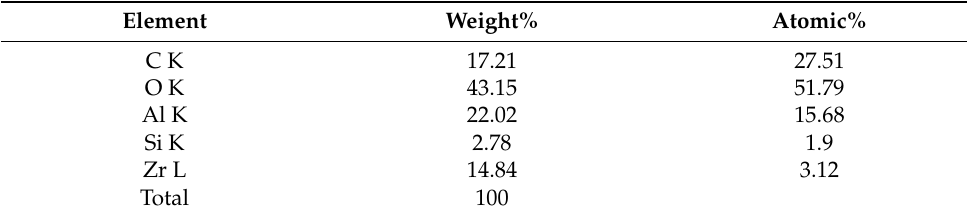
Table 3. The element composition of the fouled